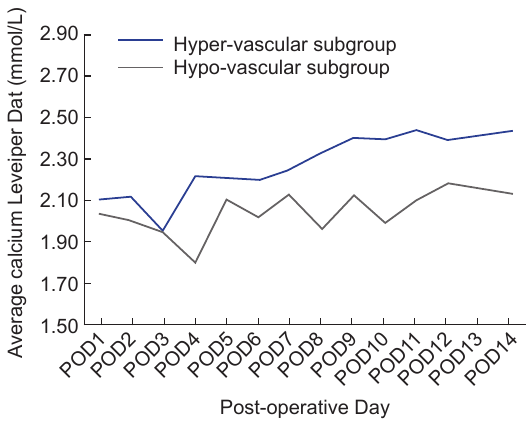
Figure 5 The average serum calcium (Ca 2+ ) monitoring curves from post-operative day 1 to day 14 for patients in hyper-vascular and hypo- vascular groups. According to the pre-operative sonographies, there were: (i) 22 cases in hyper-vascular subgroup, shown in gray line, (ii) 10 cases in hypo-vascular subgroup, shown in black line. The average serum Ca levels of patients in hyper-vascular subgroup was significantly lower than that in hypo-vascular subgroup (2.0 ± 0.1 vs. 2.3 ± 0.1, p <